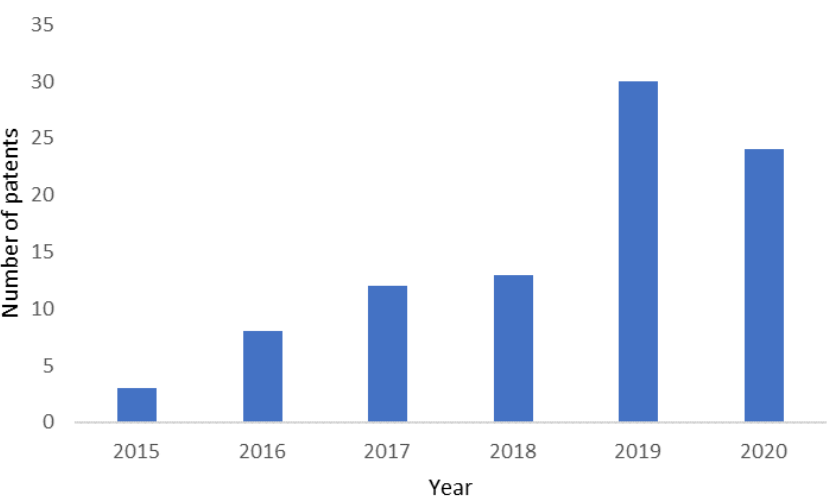
Figure 4. The number of patents issued between 2015 and 2020. Search from the PatentScope database [51] of the World Intellectual Property Organization (WIPO), using the terms “3D cancer model” and the field “front page”.